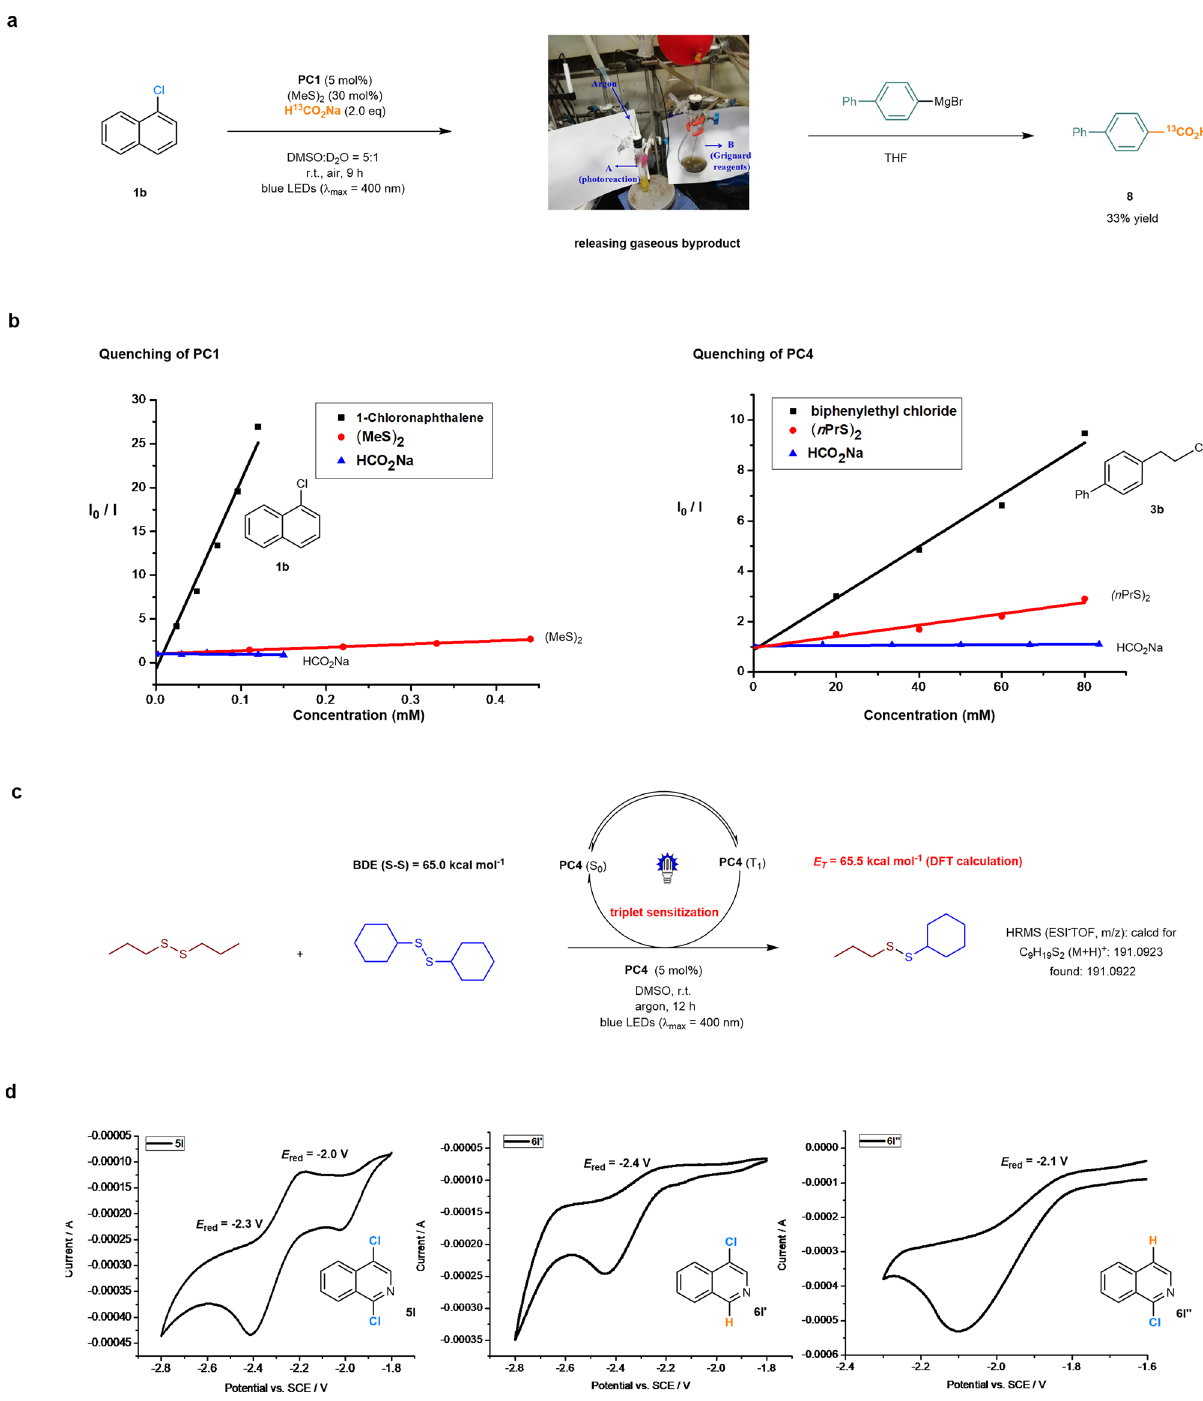
Fig. 7 Mechanistic studies. a CO 2 trapping experiments. b Stern – Volmer quenching experiments. c Thiyl radical scrambling experiments. d Cyclic voltammetry of the dichloride and the possible mono reduction products. PC, photocatalyst; r.t., room temperature; eq, equivalent; THF,